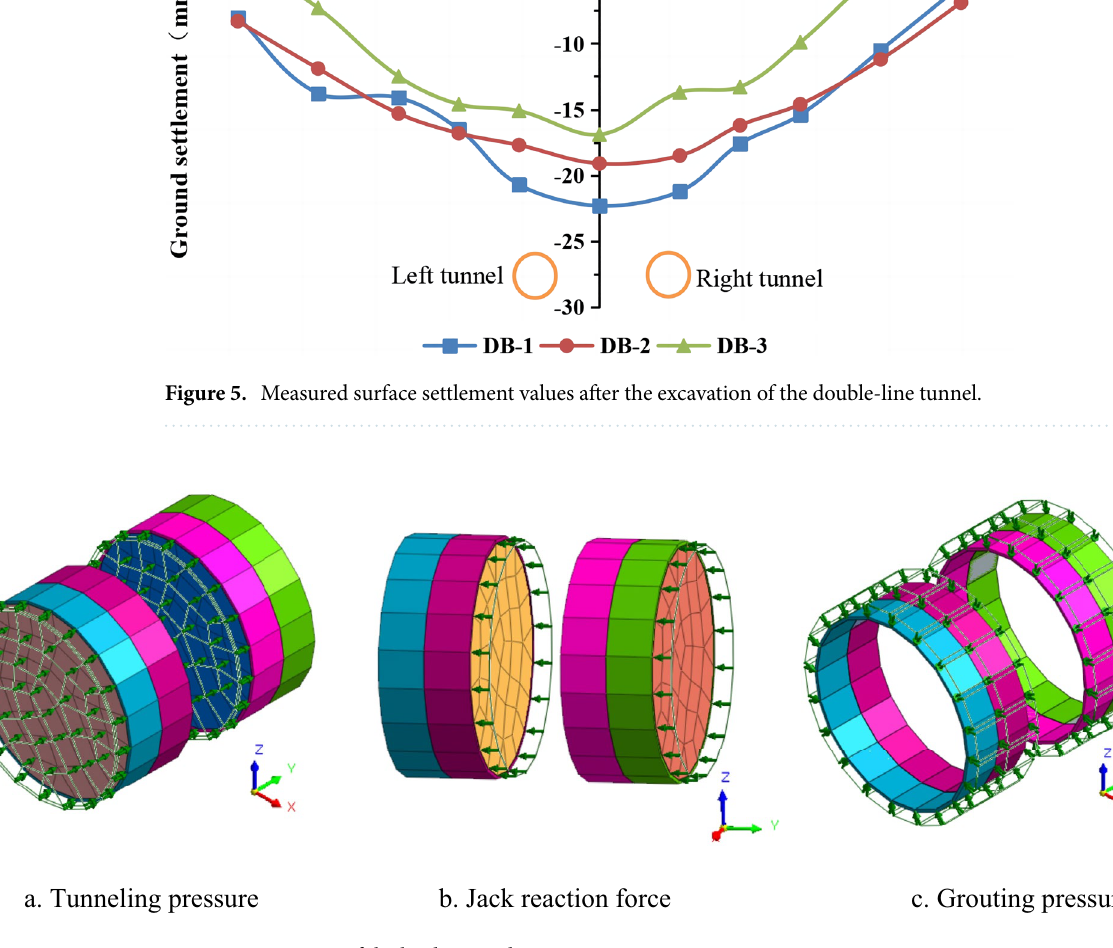
Figure 6. Diagram of the loading